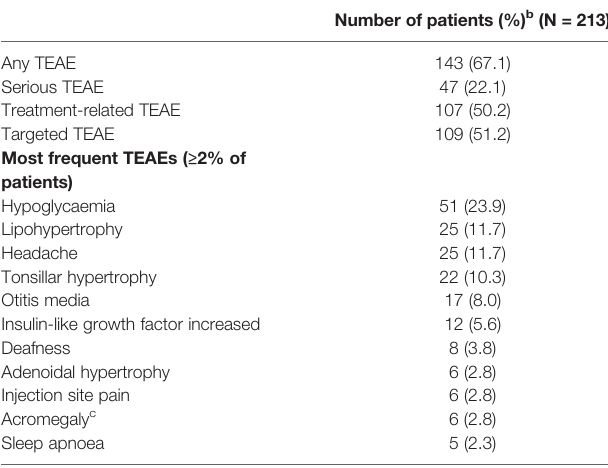
TABLE 3 | Overview of frequently reported ( ≥ 2% of patients) treatment-emergent adverse events in children receiving rhIGF-1 with growth failure a . Number of patients (%) b (N = 213) Any TEAE